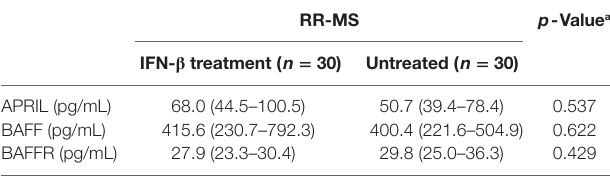
TaBle 3 | Median and interquartile range of selected mediators. rr-Ms p -Value a iFn- β treatment ( n = 30) Untreated ( n = 30)